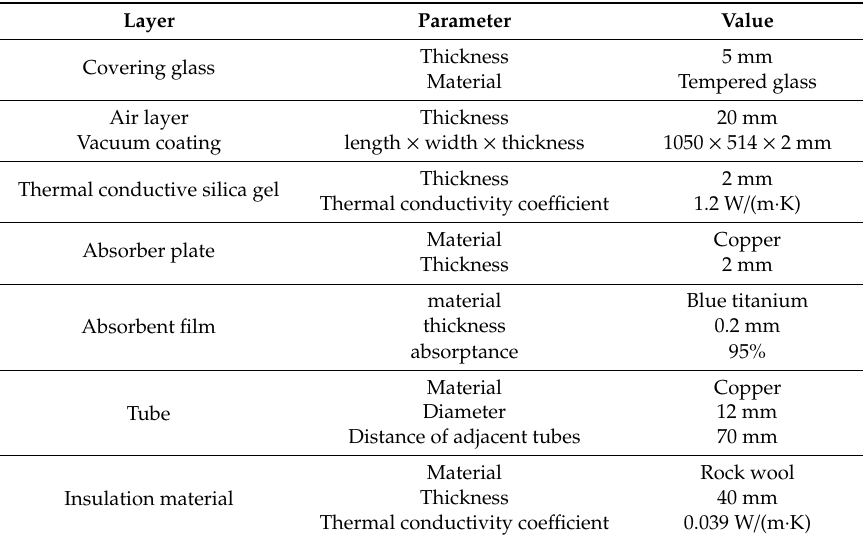
Table 3. Parameters of the solar collector.